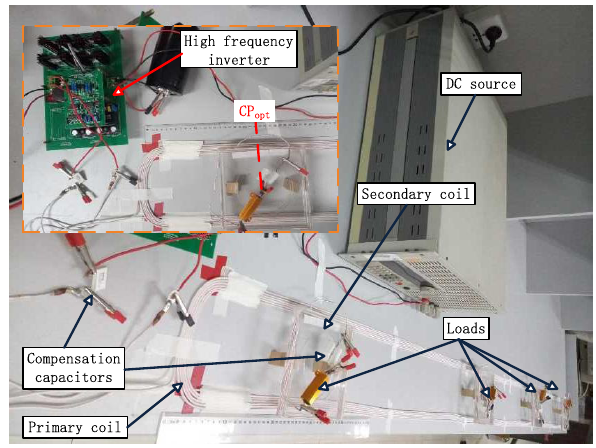
Figure 9. The experimental prototype of the opportunity EV wireless charging system with four loads.